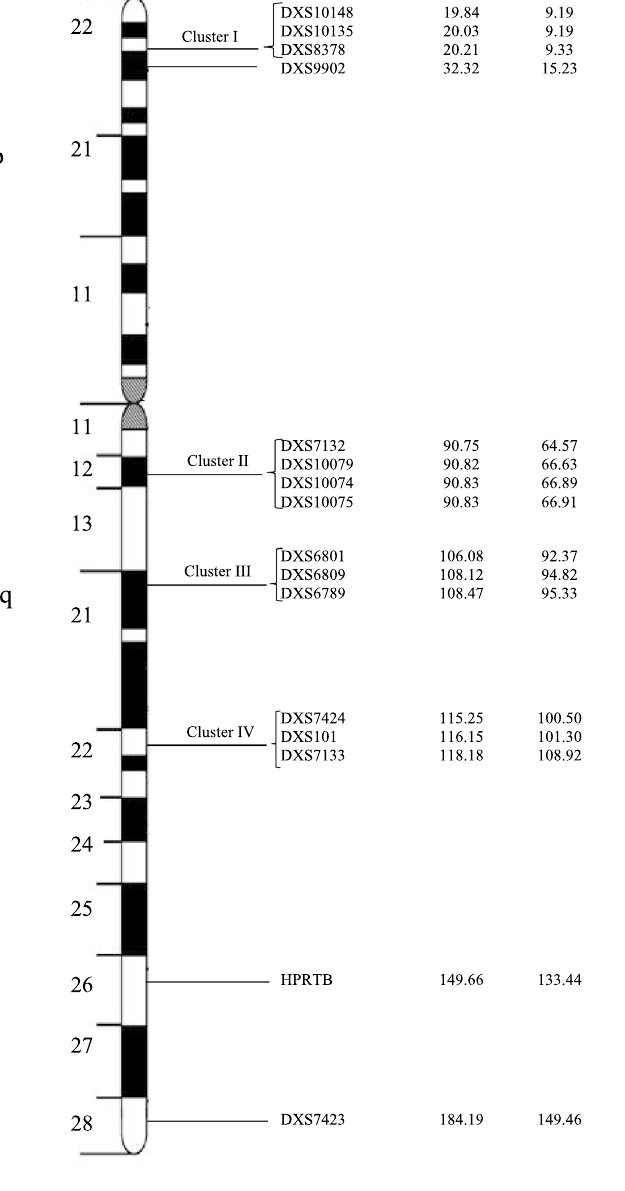
Figure 1. The ideogram of the X-chromosome describing the genetic positions of the 16 X-STR markers and their physical location. Distances from the p-telomere are shown in both cM and Mb. The order and approximate position of STRs are based upon ChrX-STR.org 2.0 database (http:// www. chrx- str.